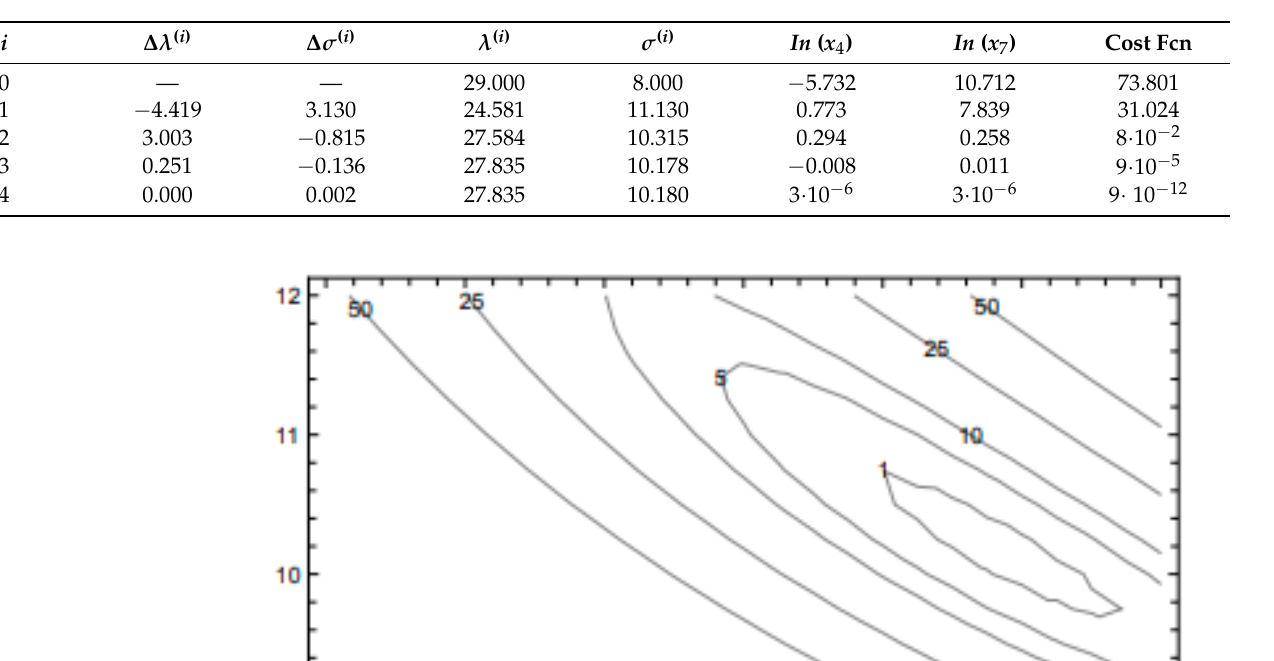
Table 4. FSM Iterates for 𝜆 = 28.